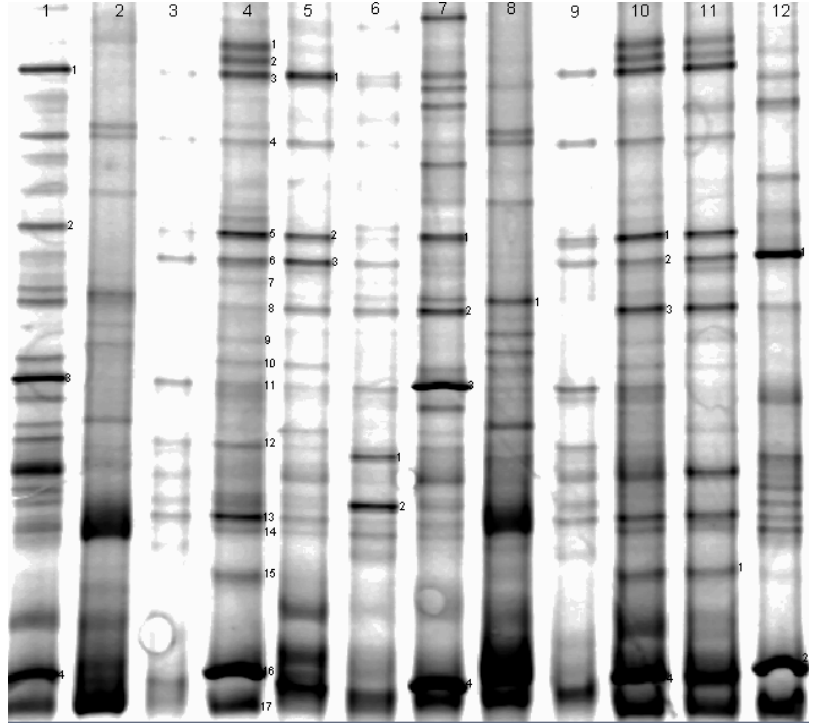
Figure A1. Larger PCR-DGGE fingerprint map for sequencing. Lanes 1-6: samples from July to December in Tiegang Reservoir; Lanes 7-12: samples from July to December in Shiyan Reservoir.